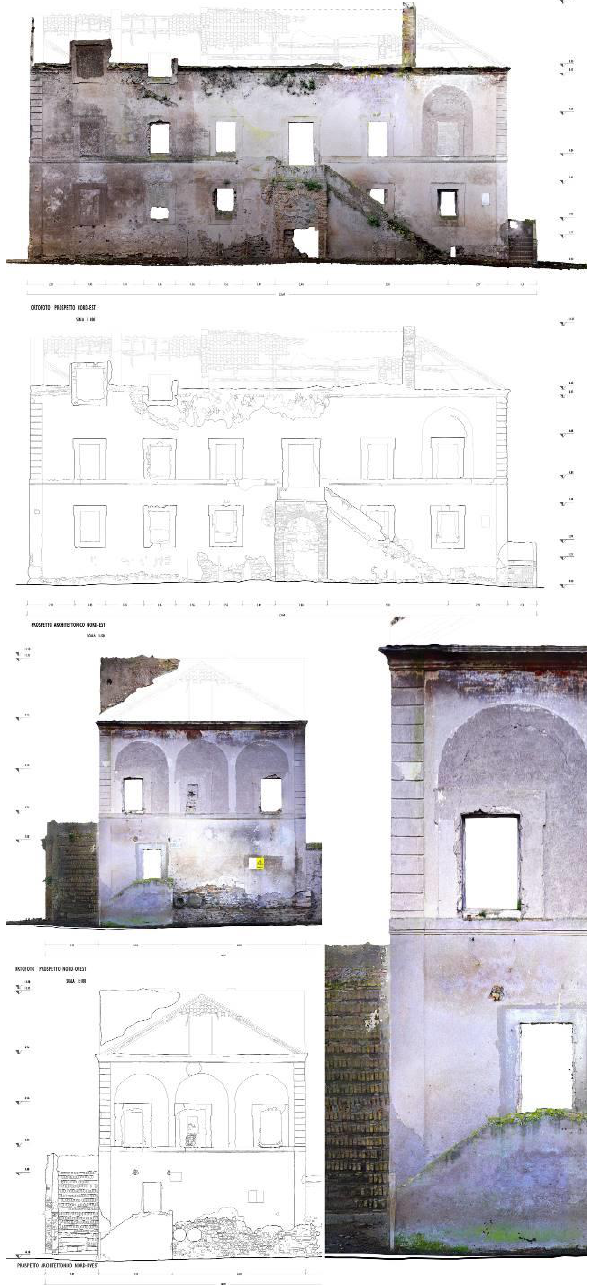
Figure 9. Survey of the elevations and identification